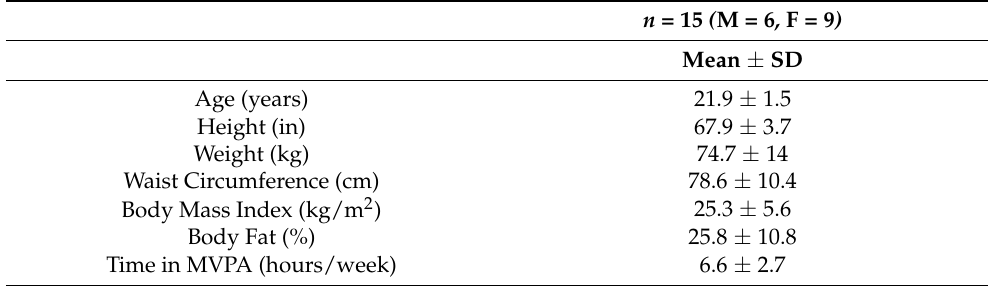
Table 2. Participant characteristics.